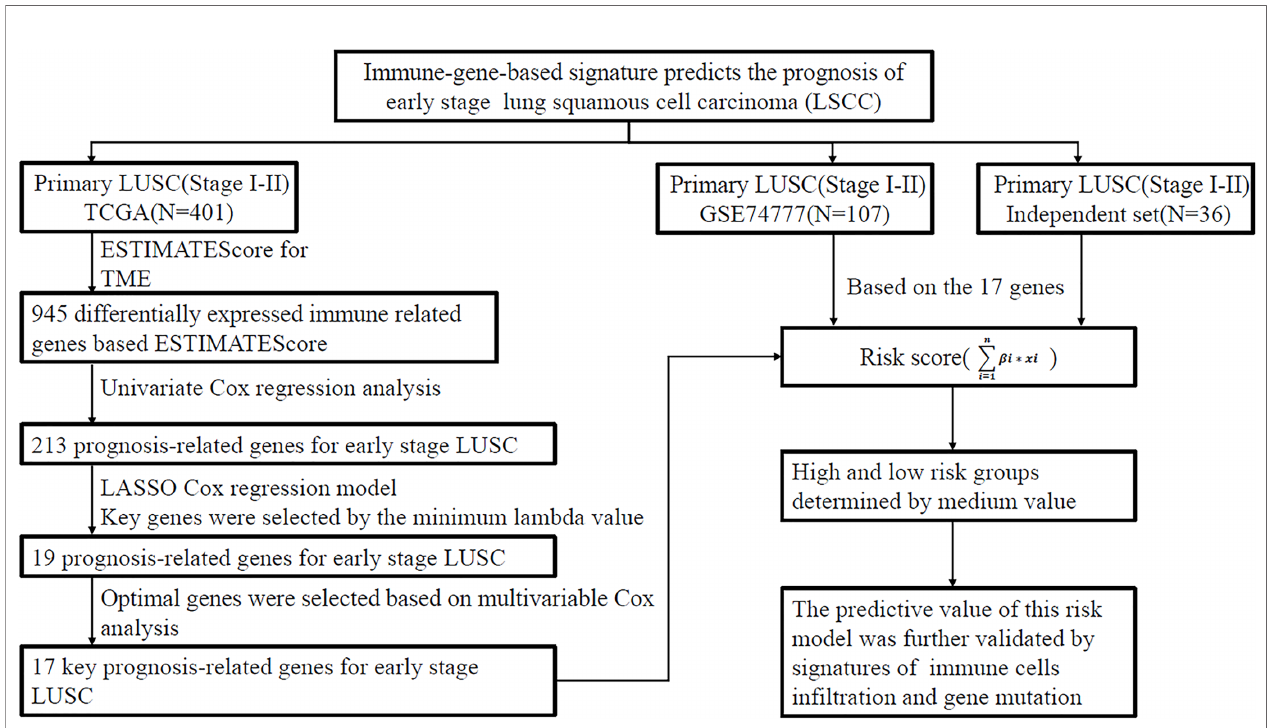
FIGURE 1 | Analysis fl ow chart showing the screening process. The three cohorts including TCGA data set, GSE74777 data set (GEO), and independent cohort (National Cancer Center). LUSC, lung squamous cell carcinoma; TCGA, The Cancer Genome Atlas Program; GEO, gene expression omnibus database; LASSO least absolute shrinkage and selection operator; ESTIMATE, Estimation of STromal and Immune cells in MAlignant Tumor tissues using Expression